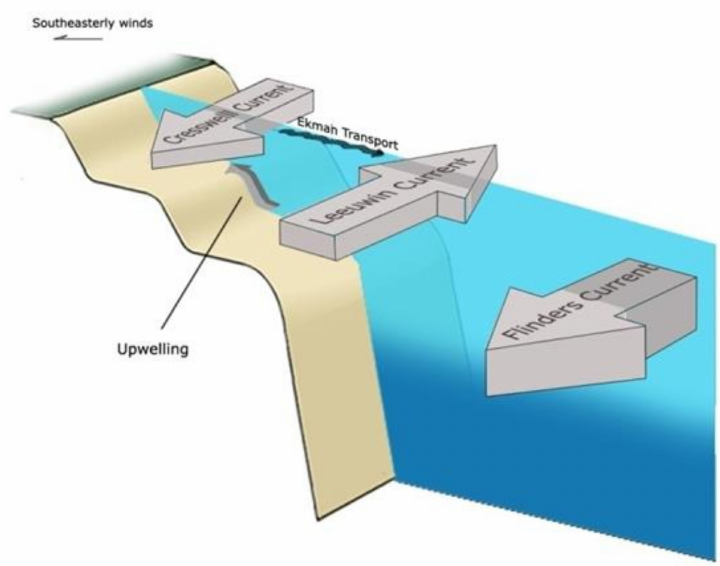
Figure 11. Schematic of the summer steady state current regime o ff Western Australia’s south